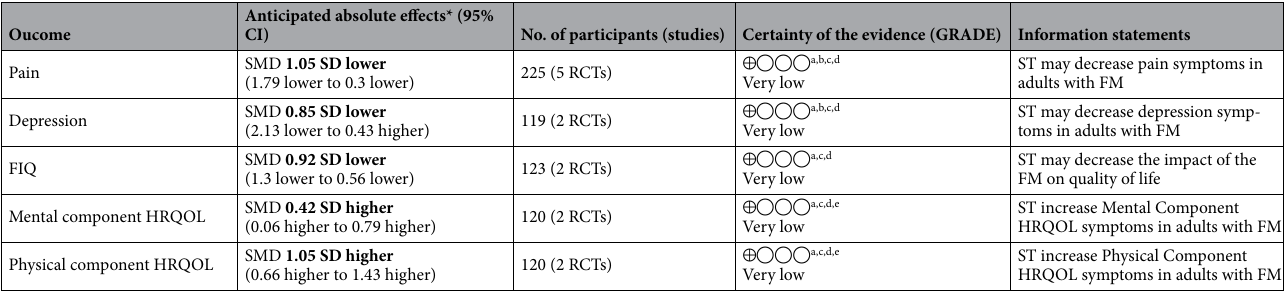
Table 3. Summary of findings table of stretching exercise intervention for fibromyalgia symptoms in adults. Significant values are in bold. *The risk in the intervention group (and its 95% confidence interval) is based on the assumed risk in the comparison group and the relative effect of the intervention (and its 95% interval confidence). a Large number of studies with high risk of bias. b Heterogeneity present and significant. c Differences in interventions and outcomes measures. d N is under 300. e Asymmetry in the pattern of results.